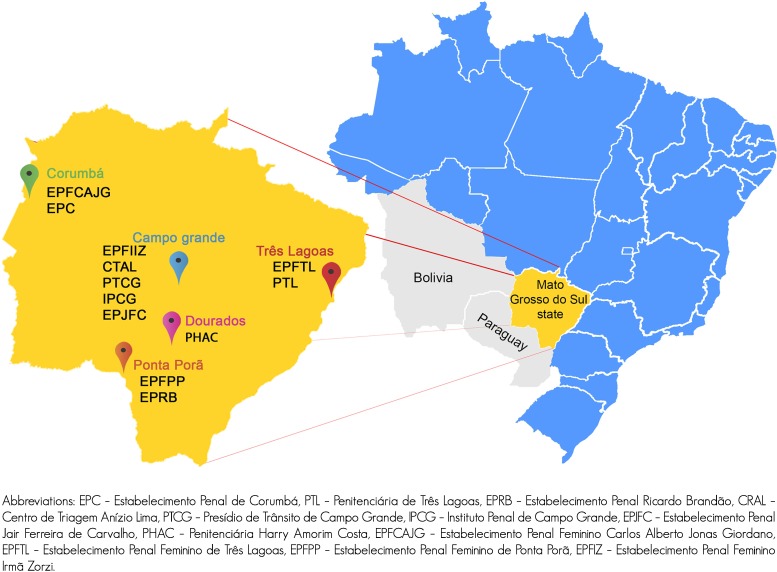
Geographical location of study prisons, Mato Grosso do Sul, Brazil (Adapted from reference 10).